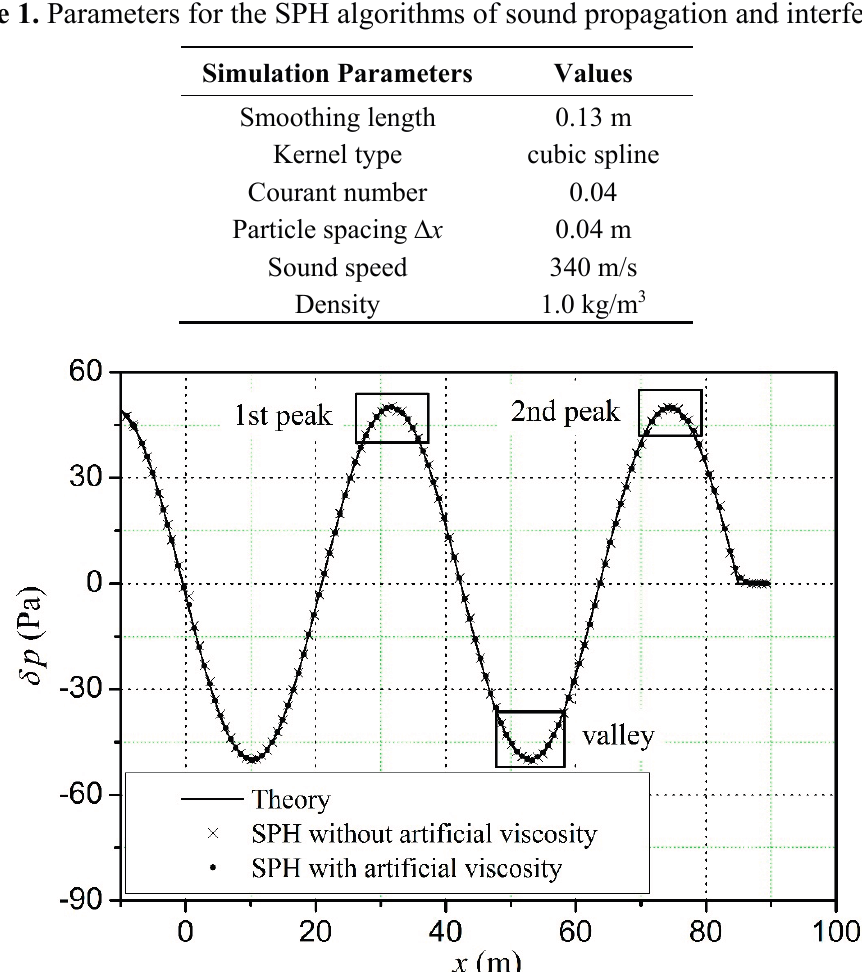
Figure 1. Sound propagation pressure of acoustic wave at t = 0.25